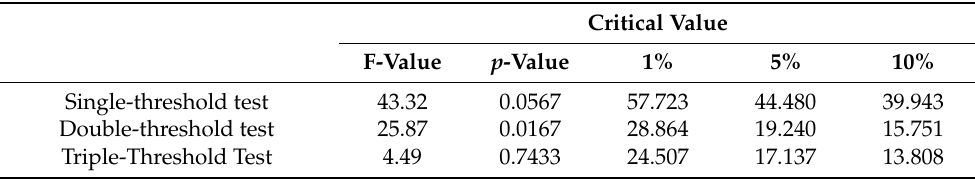
Table 5. Regression results of threshold effect